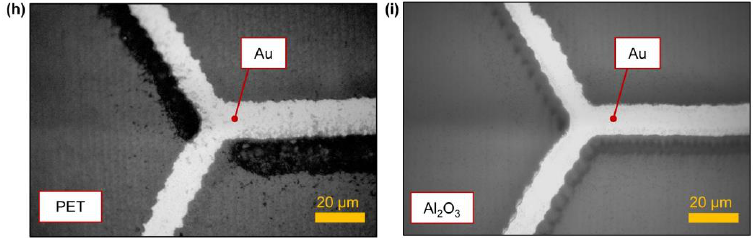
Figure 6. Optoelectronic devices fabrication using ultrashort laser pulses. ( a ) Diffraction imaging of transmission gratings by using a He – Ne laser. The sample gratings were fabricated with 0.2 ps laser pulses on a 100 nm thick Au film deposited on glass substrate. Optical microscope images of line- shaped ( b ) and dots array ( c ) transmission gratings. Diffraction images from the line-shaped grating ( d ) and dots array grating ( e ). ( f ) Diffraction efficiency of the line-shaped grating. Comparison is made with the same grating fabricated with a 4 ns laser. ( g ) Transparent conductive honeycomb structure patterning on a 100 nm thick Au on a flexible PET substrate. ( h , i ) Expanded optical micro- scope images of metal grids fabricated on PET and Al 2 O 3 substrate, respectively. Scale bars in ( d , e ), ( g ), and ( h , i ) indicate 5 mm, 0.5 mm, and 20 μm, respectively.